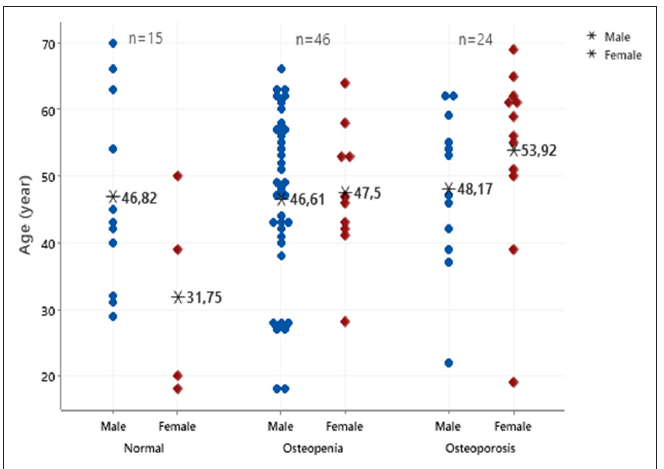
Figure 1. Individual value plot of age for patients in the study groups.